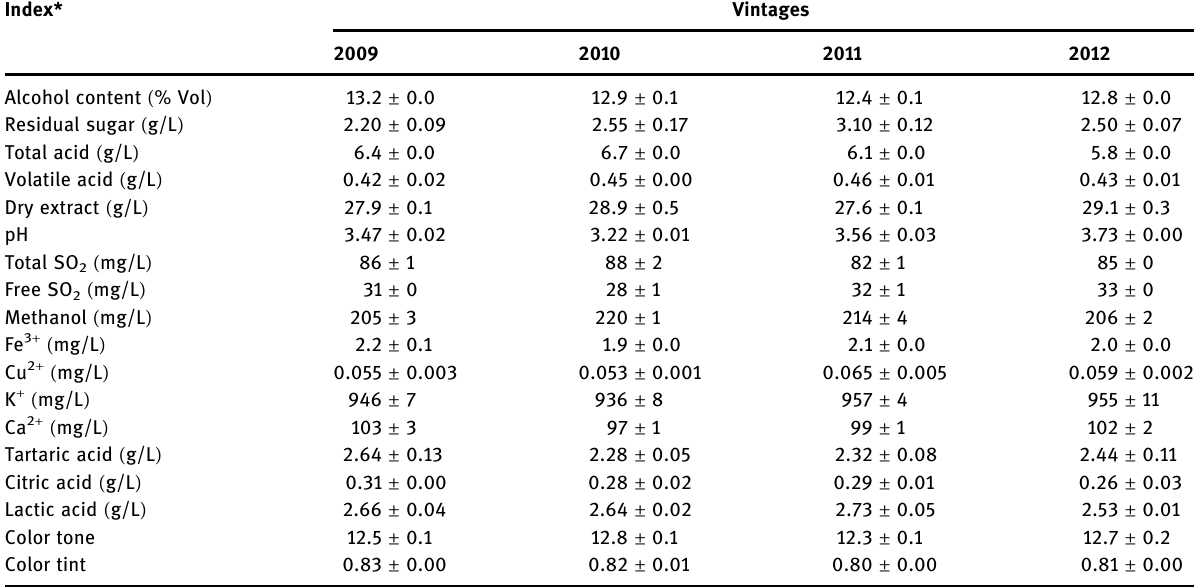
Table 3: Physical and chemical features of the wines